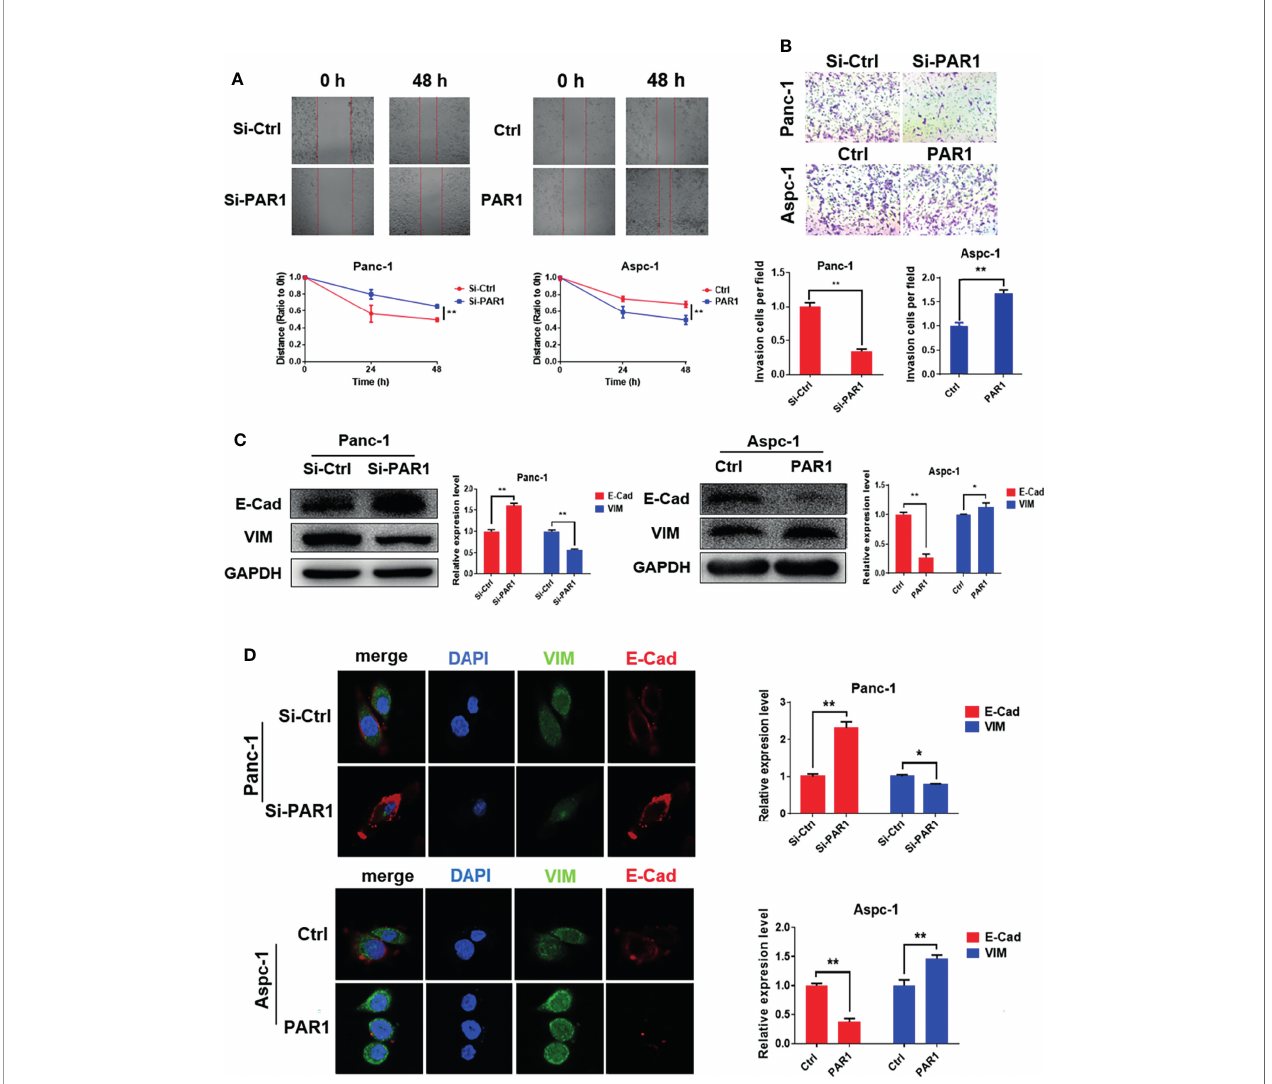
FIGURE 2 | PAR1 promotes EMT progression of pancreatic cancer cells. (A) Effect of PAR1 on Panc-1 and Aspc-1 cell migration potential detected using the wound healing assay. (B) Effect of PAR1 on pancreatic cancer cell invasion potential by using matrigel coated transwell assay. (C) Effect of PAR1 on the E-Cad and VIM expression detected by Western blot analysis. (D) Effect of PAR1 on the E-Cad and VIM expression detected by immuno fl uorescence. Data are shown as the mean ± SD (*P < 0.05, **P <